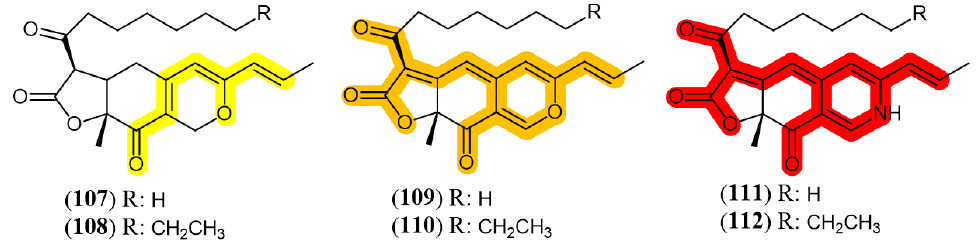
Figure 11. Monascus pigments and their chromophores (highlighted in color). Yellow: 107 : monascin; 108 : ankaflavin; Orange: 109 : rubropunctatin; 110 : monascorubrin; Red: 111 : rubropunctamine; 112 : monascorubramine [79].